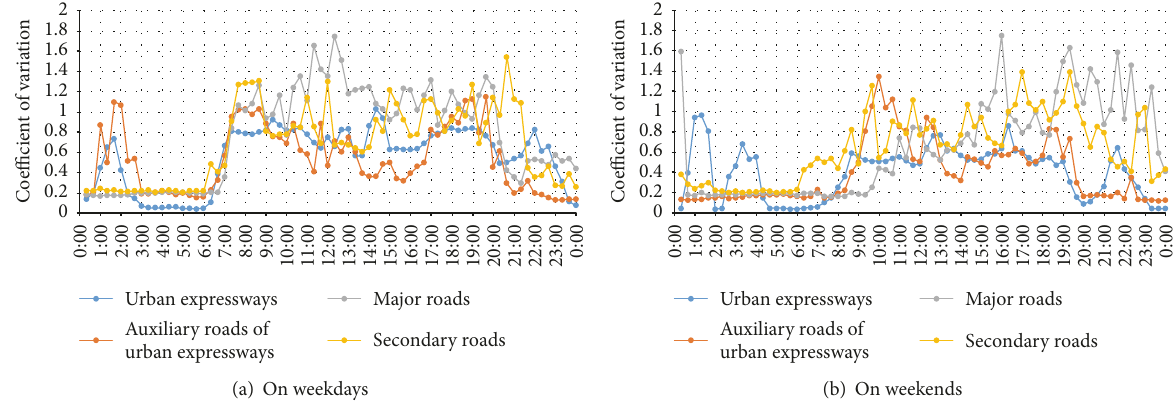
Figure 3: Coefficient of variation through the day.